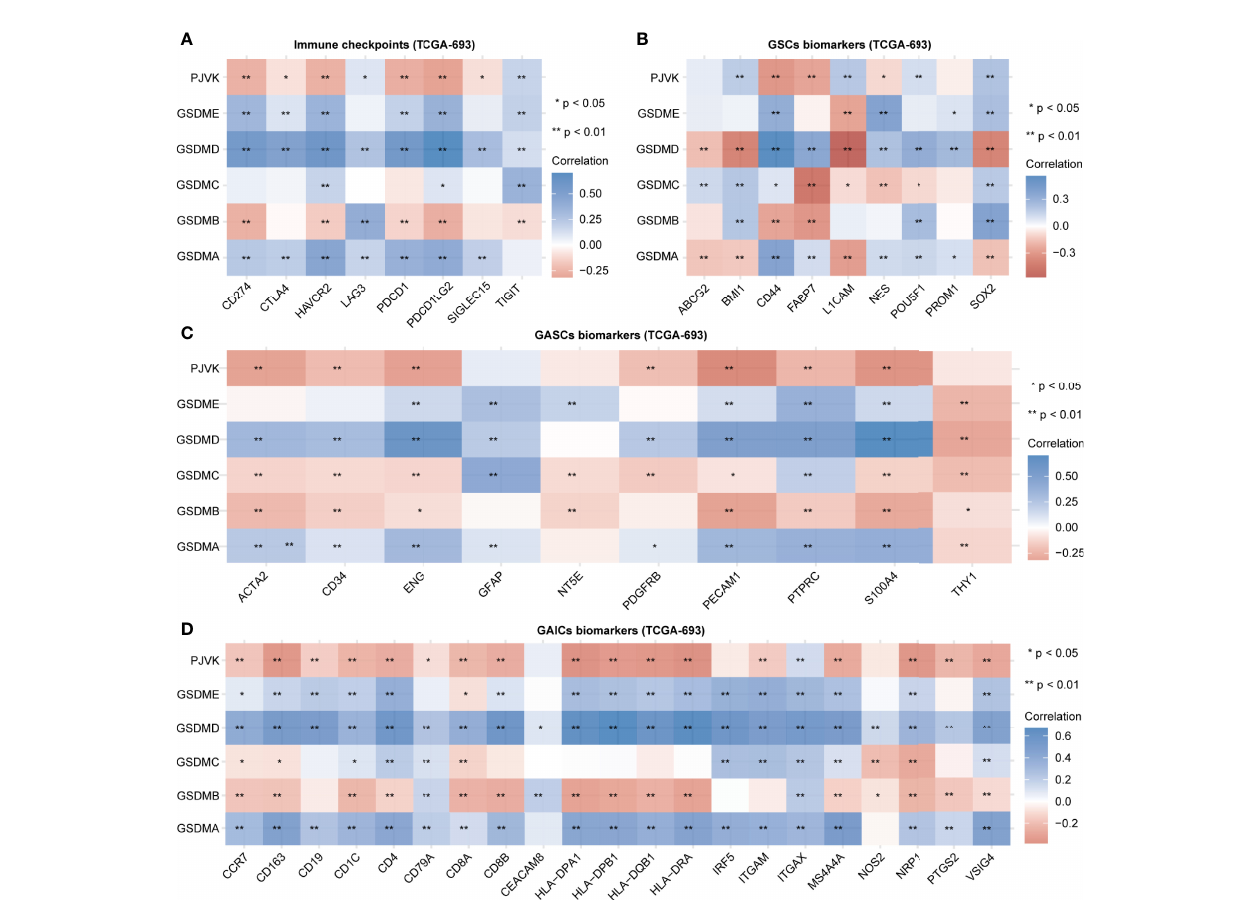
FIGURE 2 | Gasdermins are correlated with immune checkpoints and biomarkers of GSCs, GASCs, and GAICs. Heatmaps depicting correlation between gasdermin expression and immune checkpoints (A) , GSC markers (B) , GASC markers (C) , and GAIC biomarkers (D) . *P<0.05; **P<0.01; ns, not signi fi